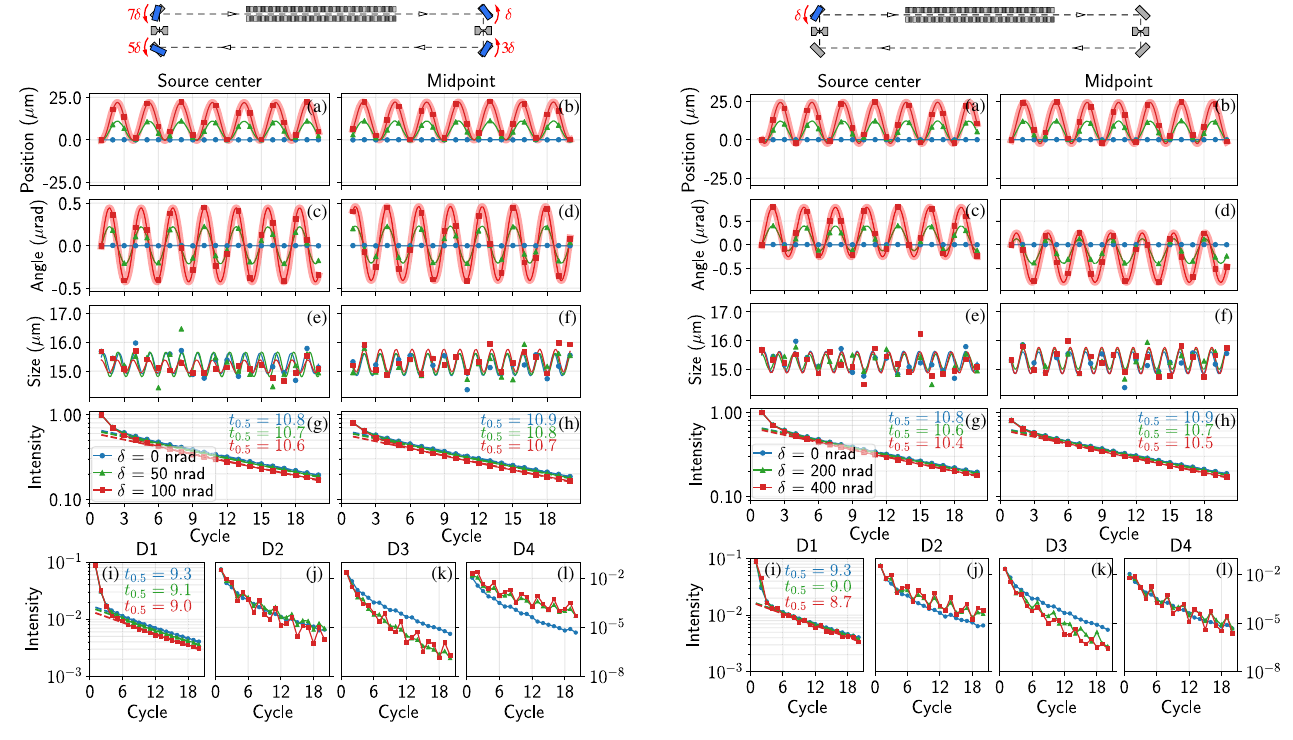
FIG. 13. Numerical simulation results of x-ray beam dynamics in the rectangular four-crystal generic cavity with systematically misaligned crystal yaw angles.